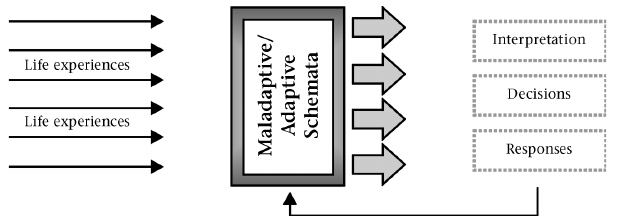
Figure 1: Schemata as a